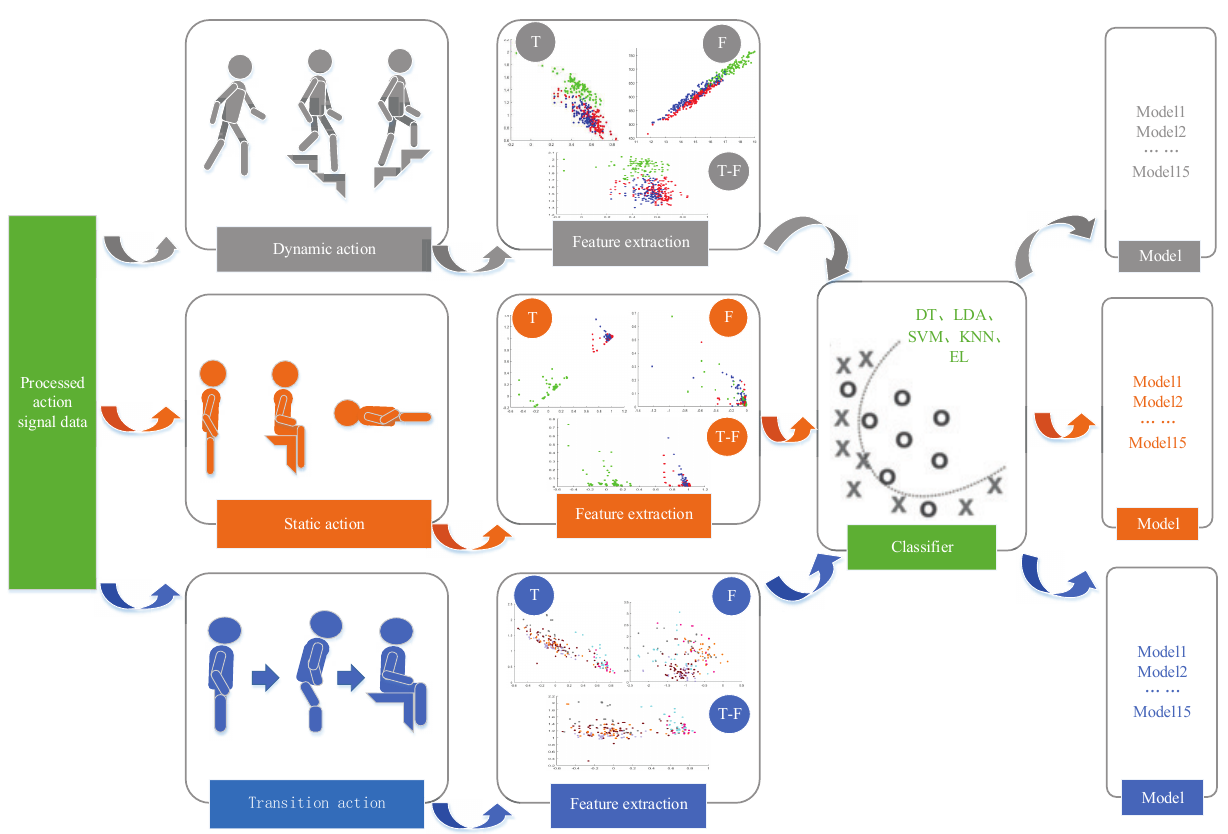
Figure 3. Feature extraction and classifier training of the